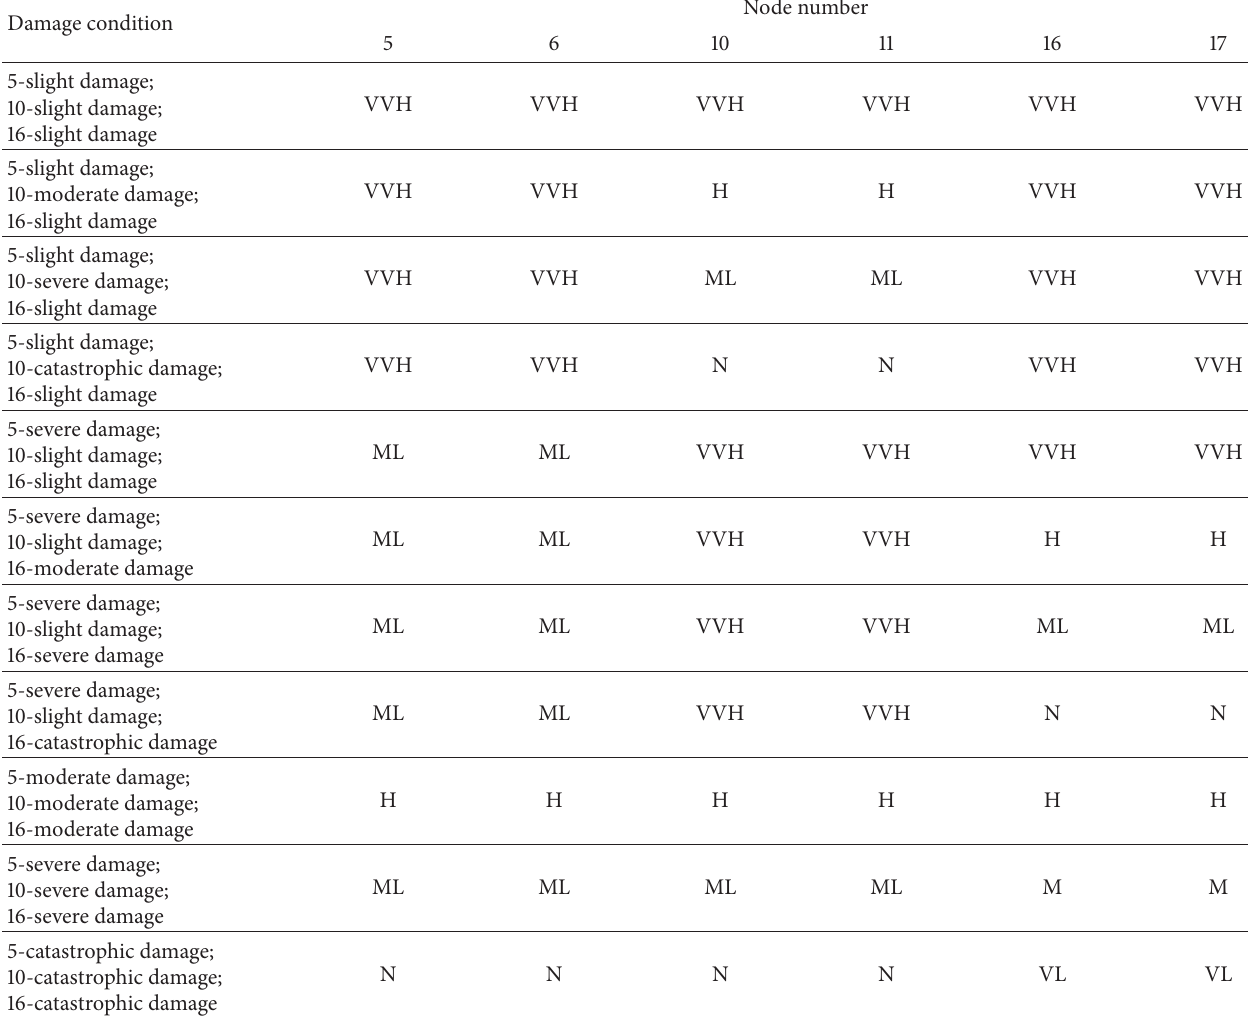
Table 8: Fuzzy rules for damage condition assessment of multiple locations.